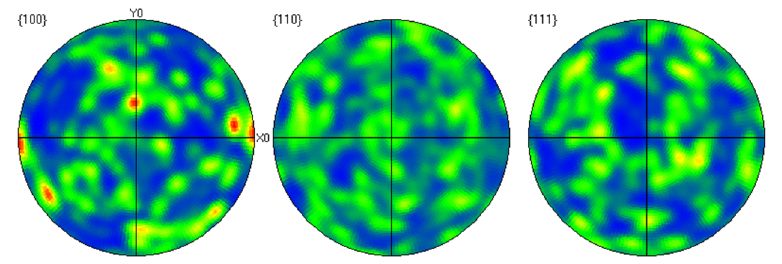
Figure 16. The pole figure distribution after the experiment.